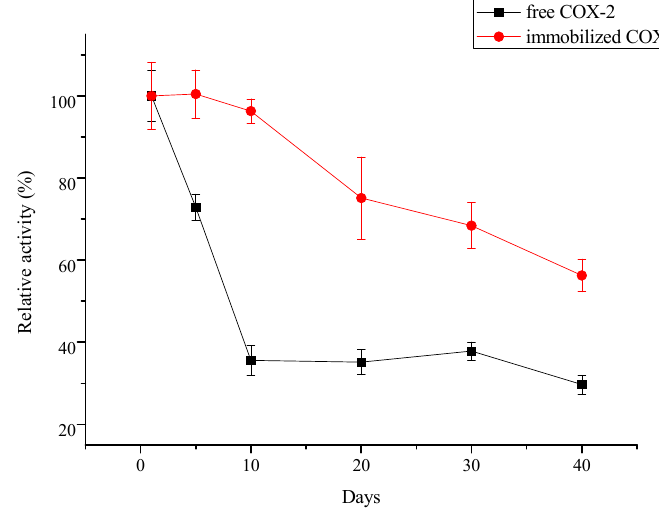
Figure 8. Storage stability of the immobilized COX-2 ( n = 3).